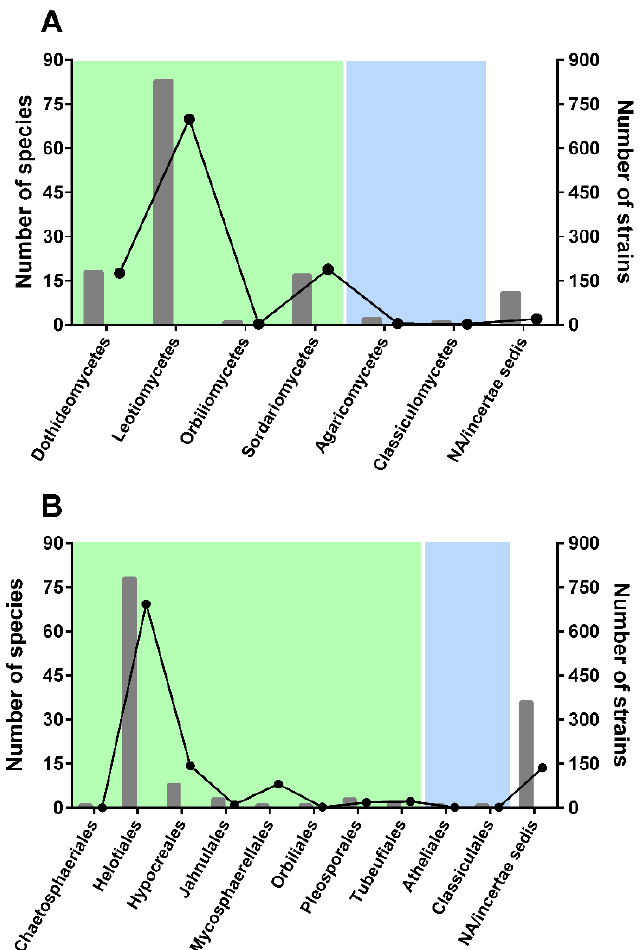
Figure 1. Distribution of aquatic hyphomycete species (bars) and strains (lines) among classes ( A ) and orders ( B ) of ascomycetes (green) and basidiomycetes (blue).